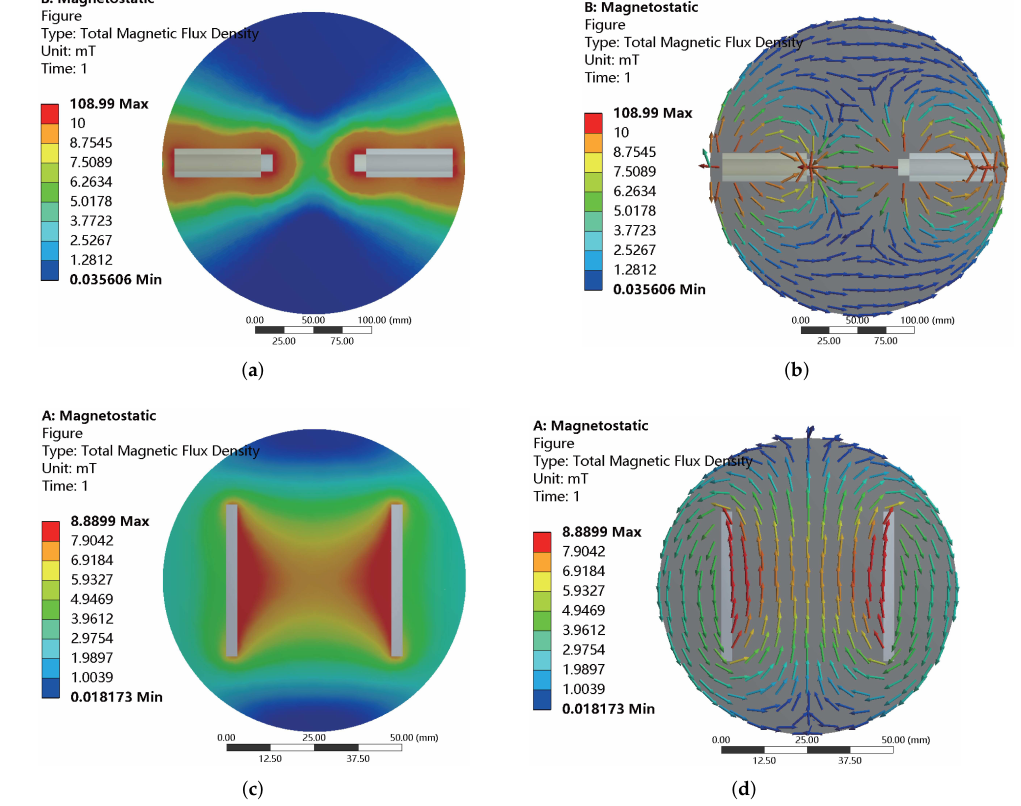
Figure 4. Simulation results of magnetic flux density distribution for the coils along ( a , b ) x-axis or y-axis, and ( c , d ) z-axis with an input current of 1 A. ( b , d ) Simulation results with vectorized